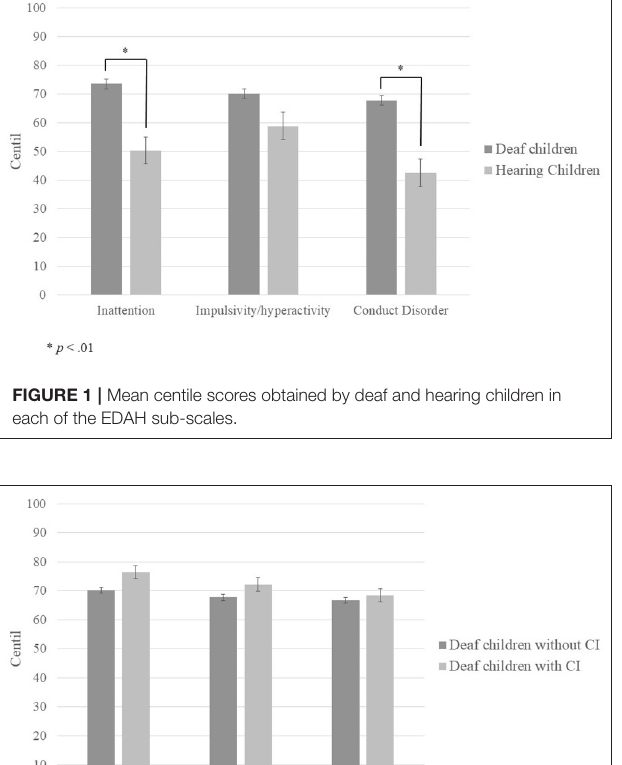
know the sign of the potential difference. We used the